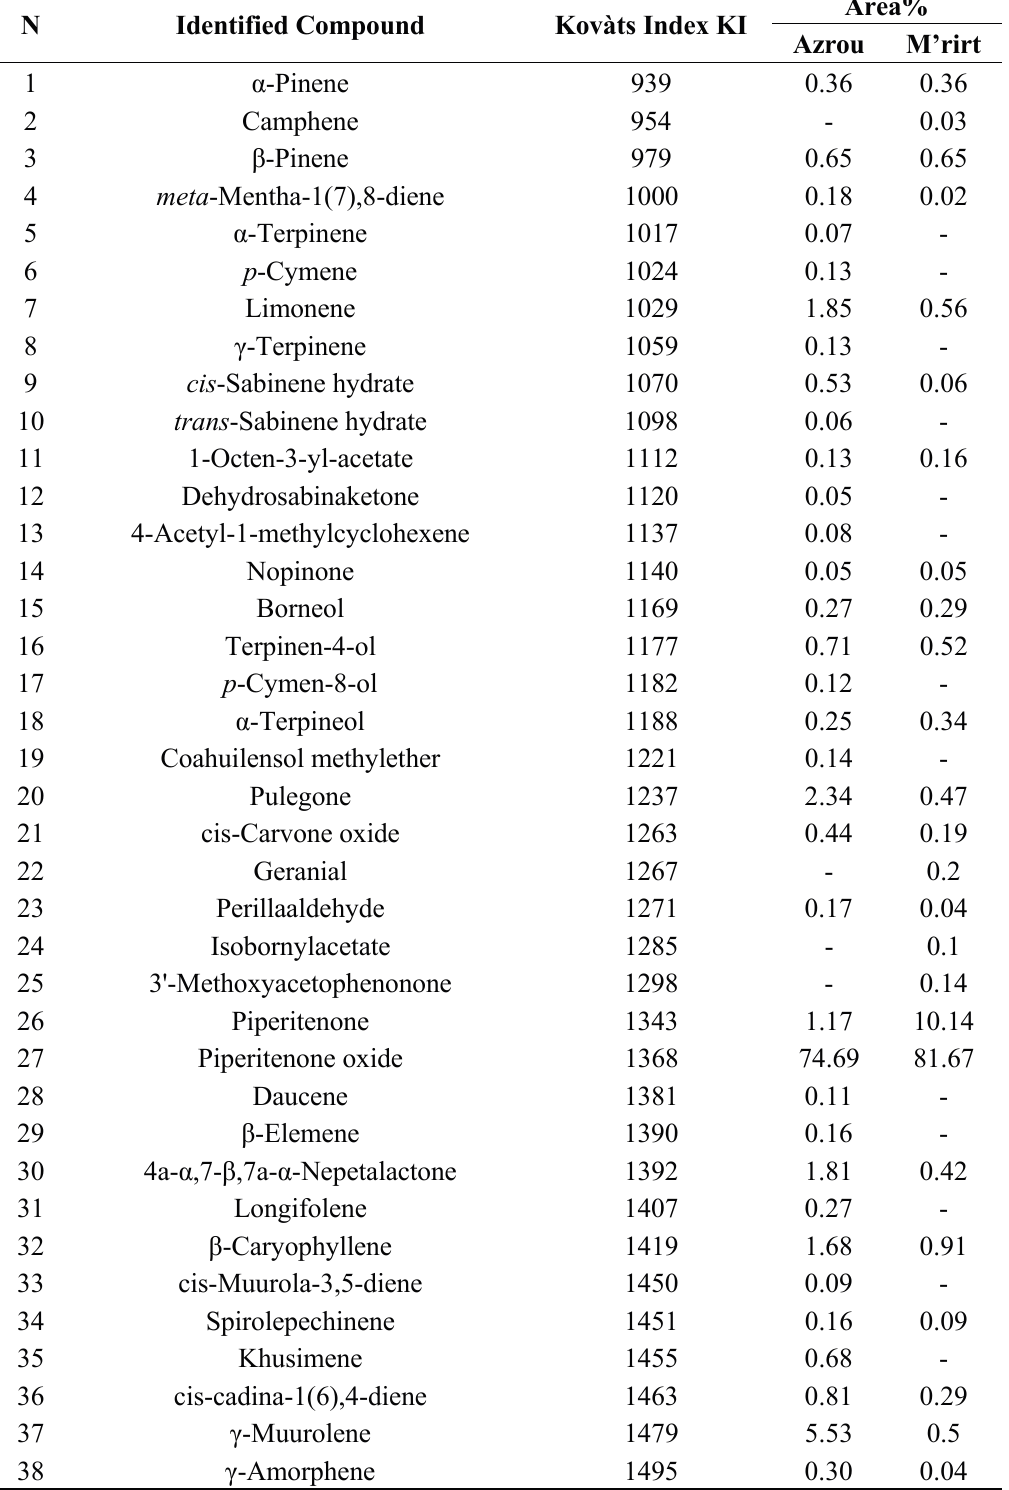
Table 2. Example of EOMS chemical composition from two Moroccan localities